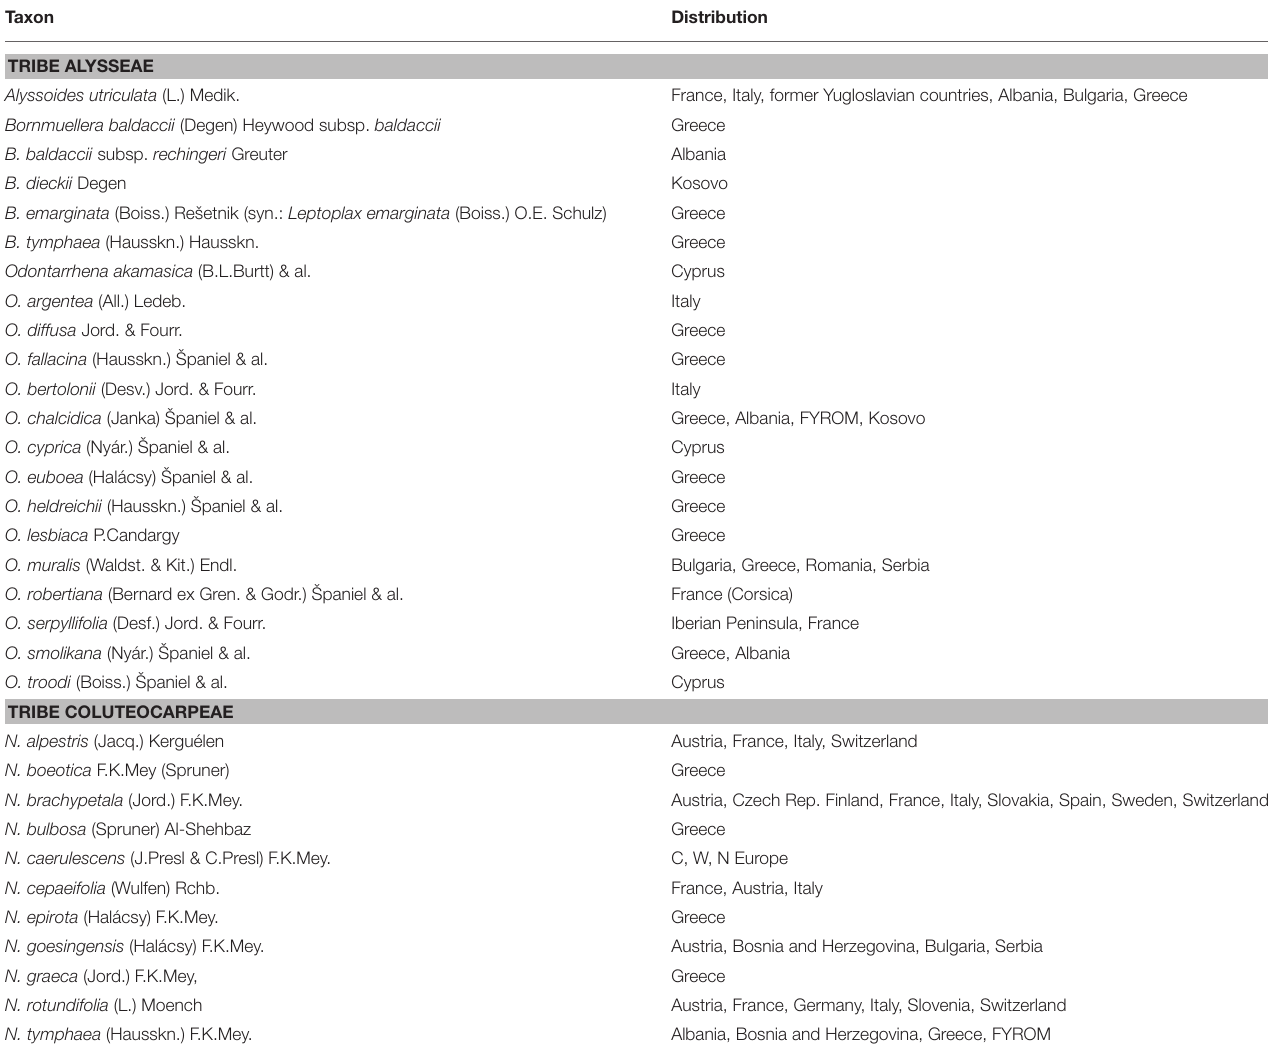
TABLE 1 | Nickel-accumulator species in tribes Alysseae and Coluteocarpeae (Brassicaceae) native to Europe (including Cyprus); nomenclature of Noccaea and Alysseae follows respectively Al-Shehbaz (2014) and Spaniel et al. (2015; see also Alybase; http://www.alysseae.sav.sk/checklists/search). Taxon